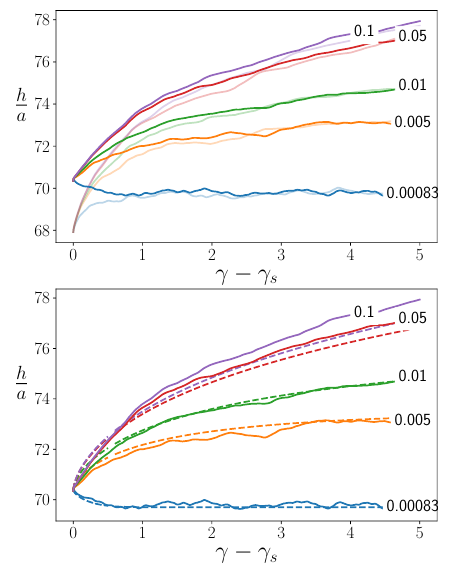
Figure 4. Evolution of the top wall height during the transients. (Top) Simulations starting with two di ff erent J i = 1 × 10 − 4 (lightly colored lines) & 1 . 6 × 10 − 3 (dark colored lines), but same J f . (Bottom) Comparison between simulations (solid lines) and model predictions (dashed